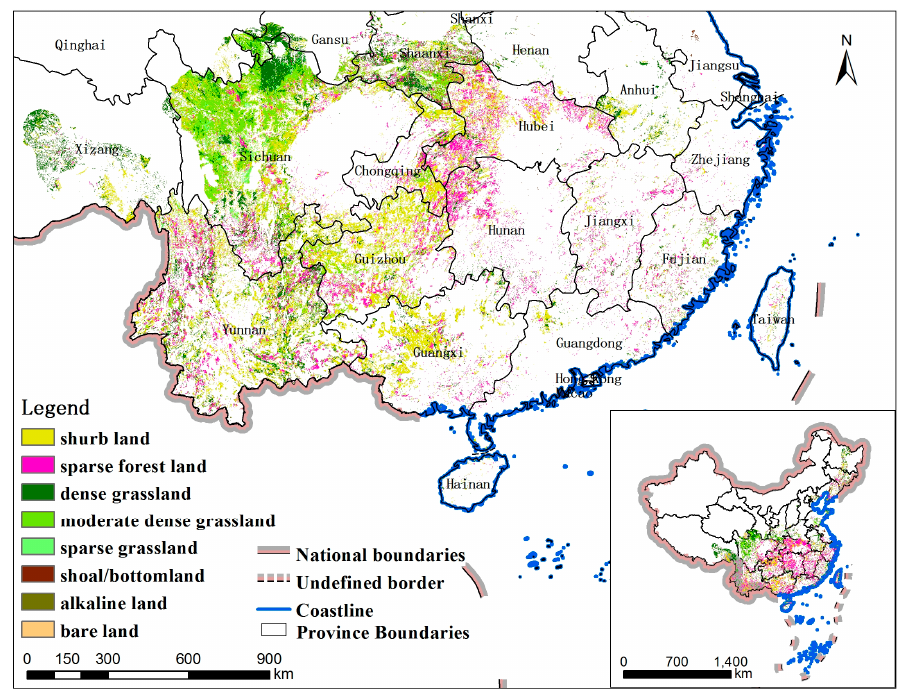
Figure 2. Marginal land resources suitable for switchgrass planting.